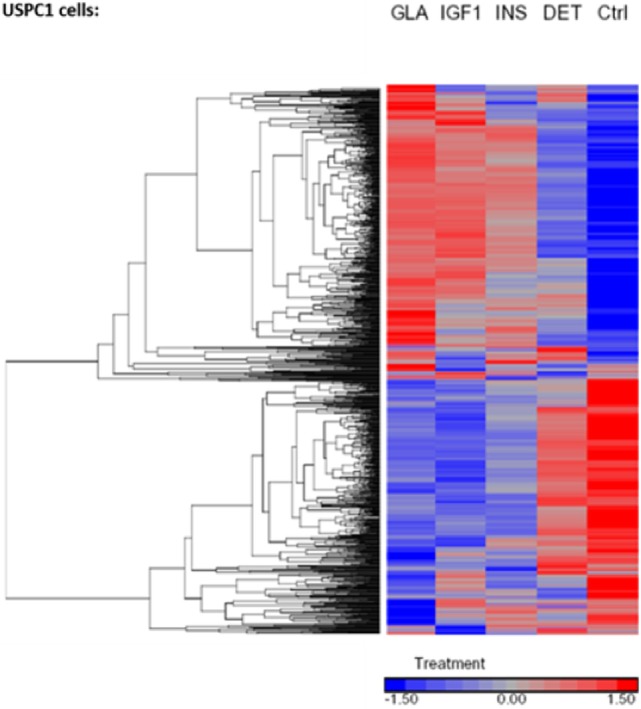
Hierarchical clustering map of differential gene expression in USPC-1 cells. Heatmaps of microarray results in the USPC-1 cell line after treatment with insulin glargine, detemir, IGF1, and regular insulin. The figure depicts a heatmap of differentially expressed genes (FC > 1.5 or <−1.5). The scale below indicates the relative changes in gene expression represented by red and blue colors. Upregulated genes are shown in red and downregulated genes are shown in blue. FC, fold change.